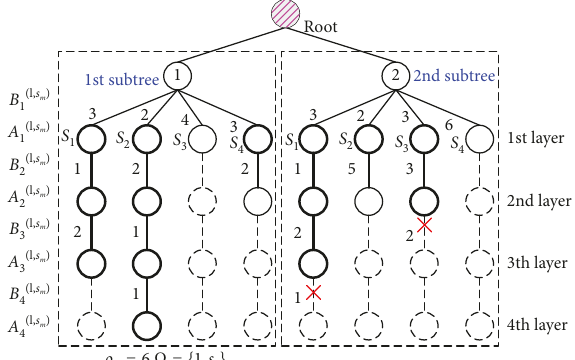
Figure 1: The tree structure of 2 M 3 , 2 , 2 , 1 (cid:31) [ ]